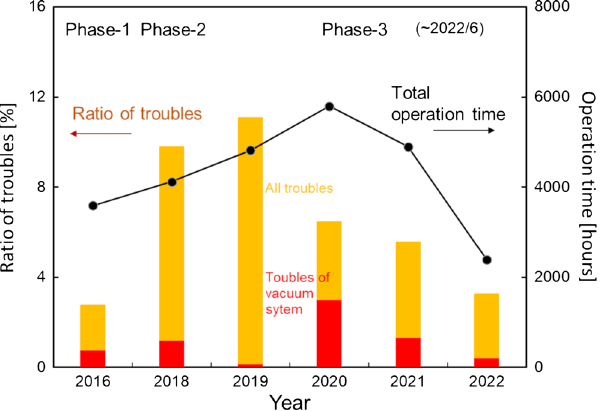
FIG. 5. Total operation time and the number of faults by year. The number of faults related to the vacuum system is indicated in